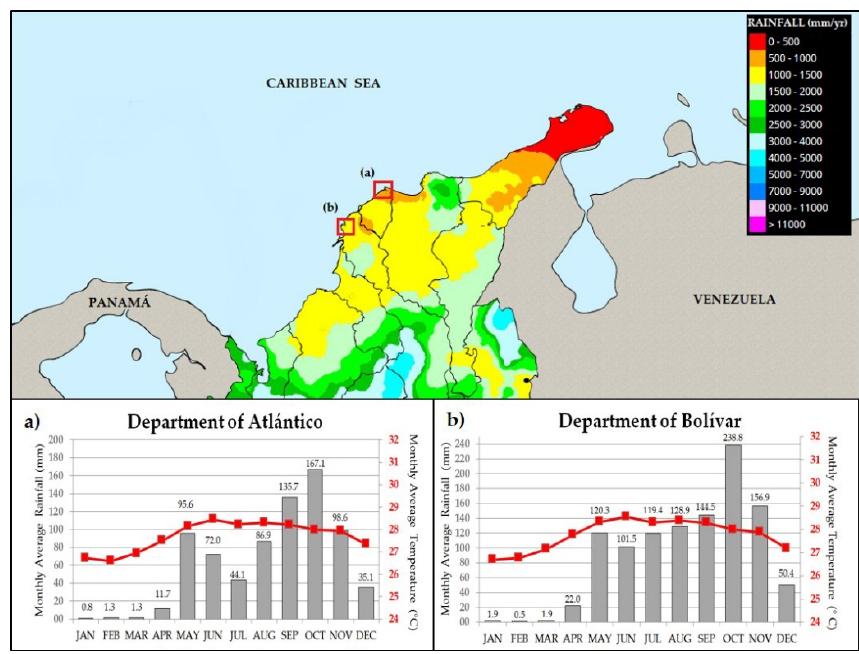
Figure 2. Rainfall and temperature variations at Colombian Caribbean coast (data recorded in the 1980–2010 period- IDEAM [24]): ( a ) Department of Atlántico; ( b ) Department of Bolivar.